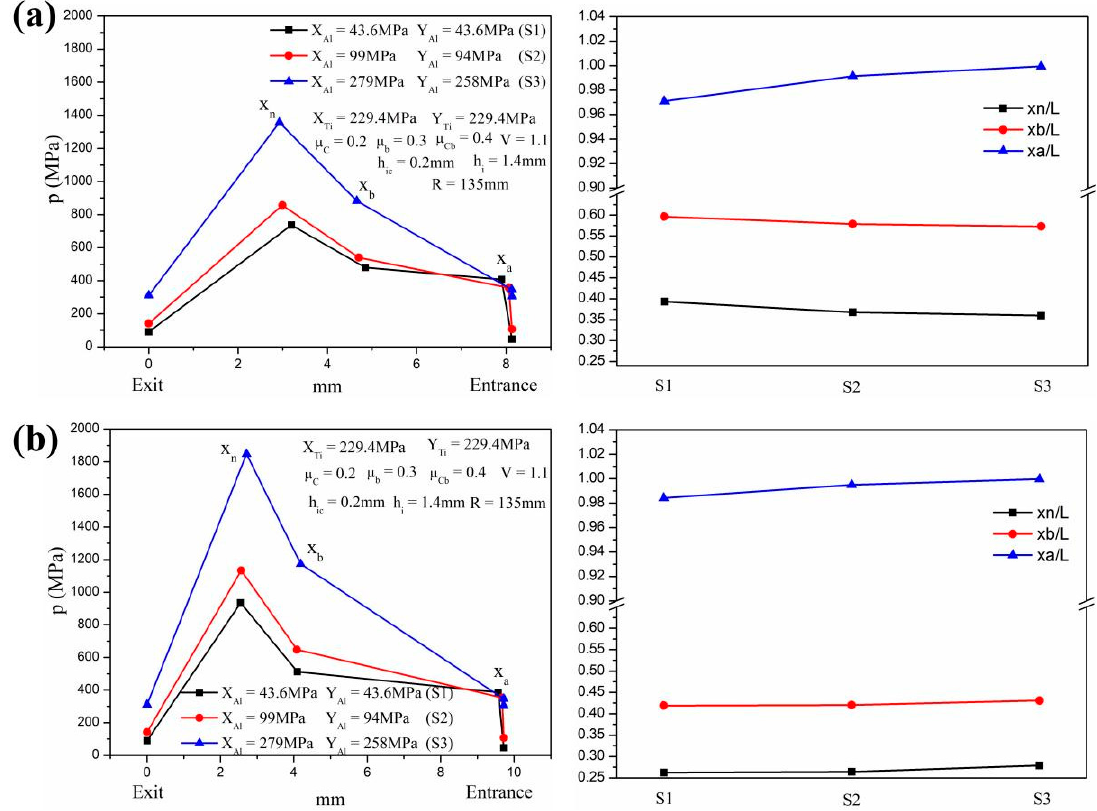
x , x and x , in the defor- a b n